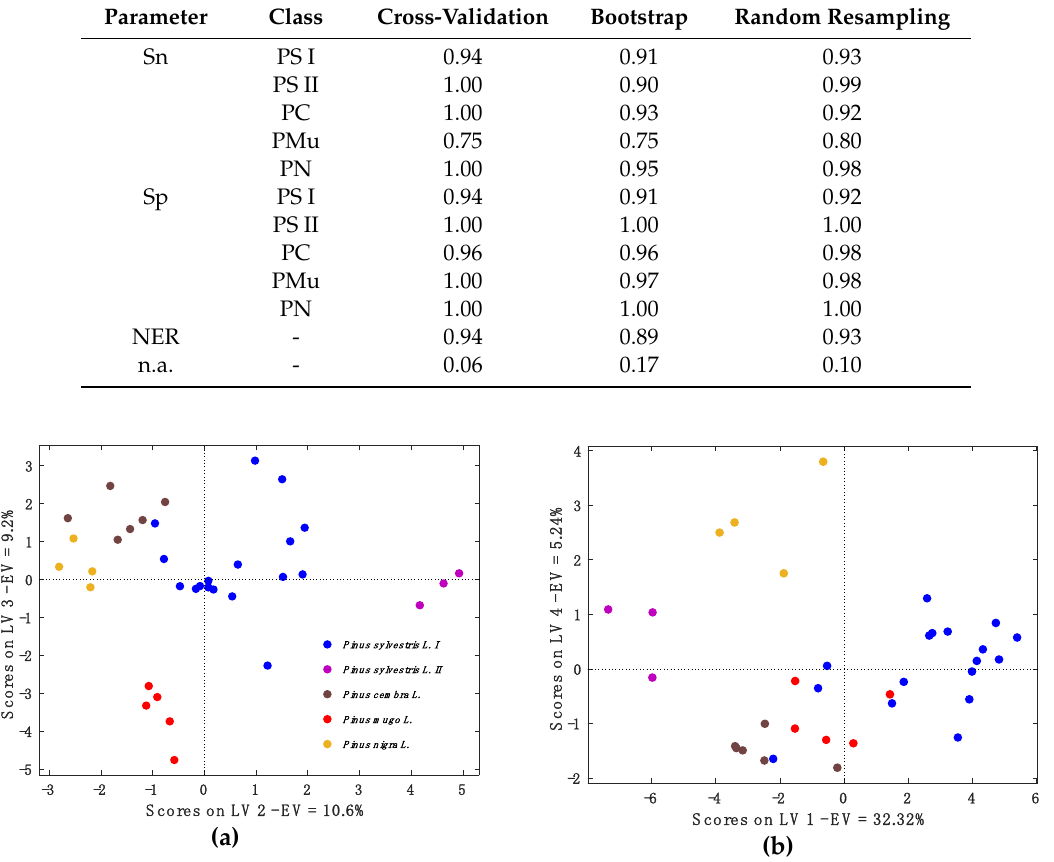
Figure 6. ( a ) γ -cadinene as potential chemical marker for characterizing primary EOs of PS I. Significance was tested using ANOVA followed by Tukey post-hoc test with p < 0.01: ** and p < 0.001: ***. ( b ) Mass spectrum of γ -cadinene. 3. Materials and Methods 3.1. Chemicals and Solvents C7–C30 saturated alkanes and heptane (puriss, p.a., Reag. Ph. Eur., ≥ 99%, n -heptane basis GC) were purchased from Sigma-Aldrich (St. Louis, MO, USA). Pure water was generated from an in- house water purification system from Labtec (Villmergen, Switzerland). Helium 6.0 and Hydrogen 5.0 were purchased from PanGas (Dagmersellen, Switzerland).